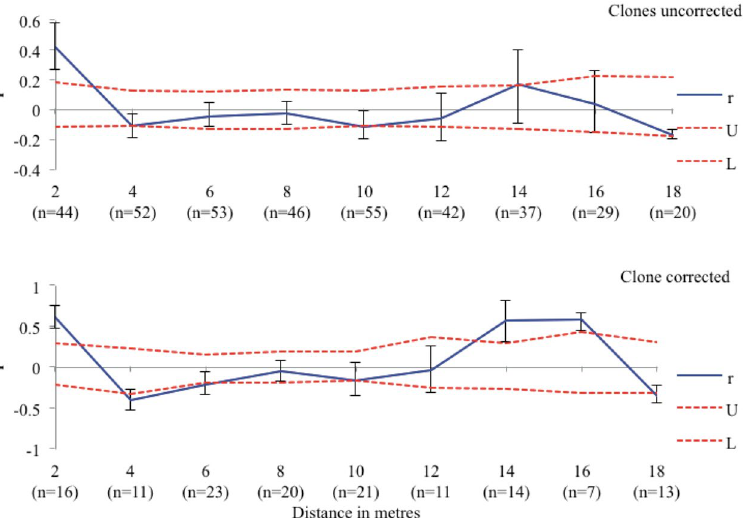
Figure 5. Spatial autocorrelation for site GST located at Kosciuszko National Park for datasets with clones included and clone corrected. The 95% confidence intervals about the r value were determined via bootstrapping and upper and lower bounds for the 95% confidence intervals about the null hypothesis of no spatial structure ( r = 0) determined by random